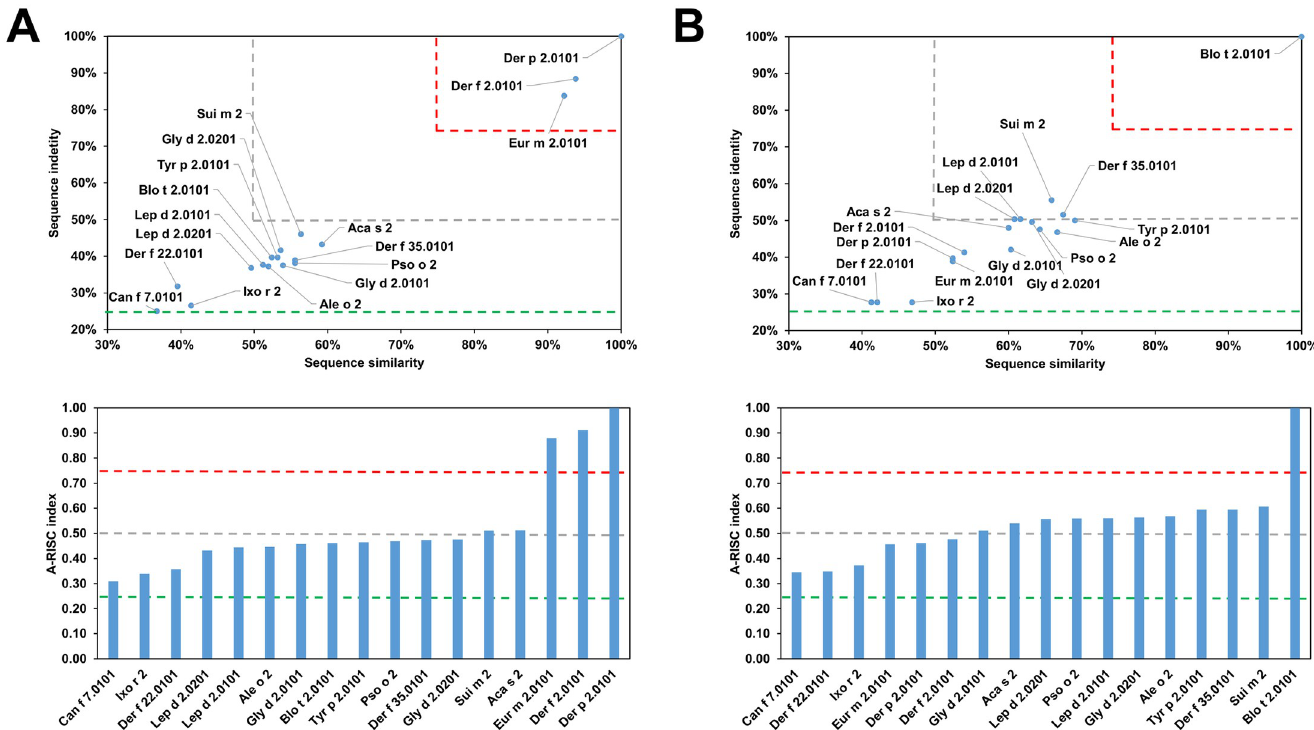
Fig 4. Plots showing relative homology and A-RISC indexes of allergens from the NPC2 family. Comparison of family members to Der p 2.0101 (A) and Blo t 2.0101 (B). Red, gray, and dark green dashed lines indicate respectively 75%, 50% and 25% sequence identity and similarity, or 0.75, 0.50 and 0.25 A-RISC values.